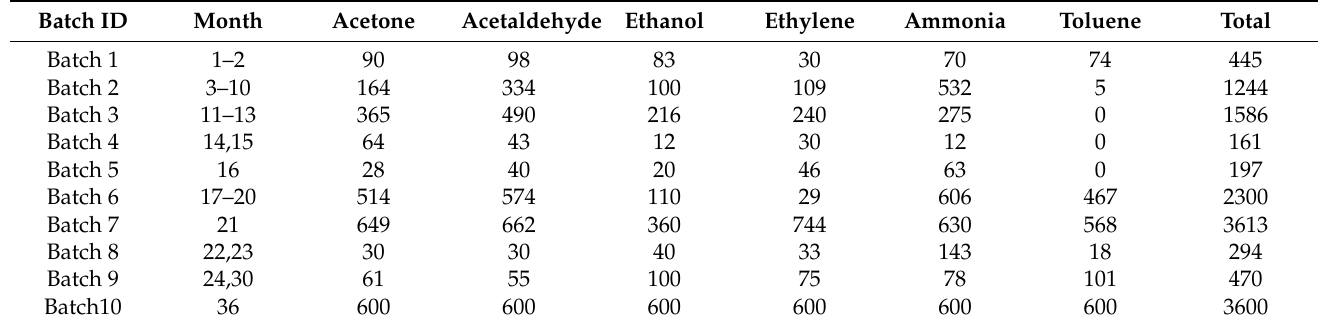
Table 1. Data volume for different sample gases in 10